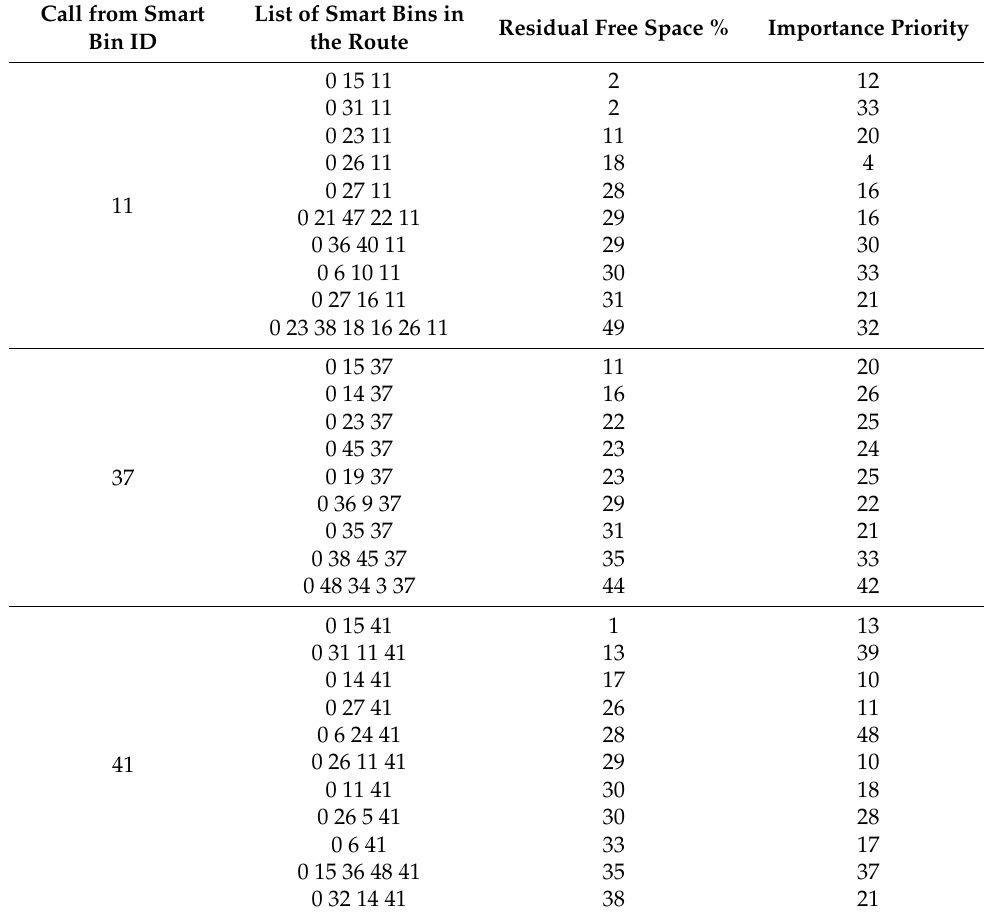
Table 1. Experiment